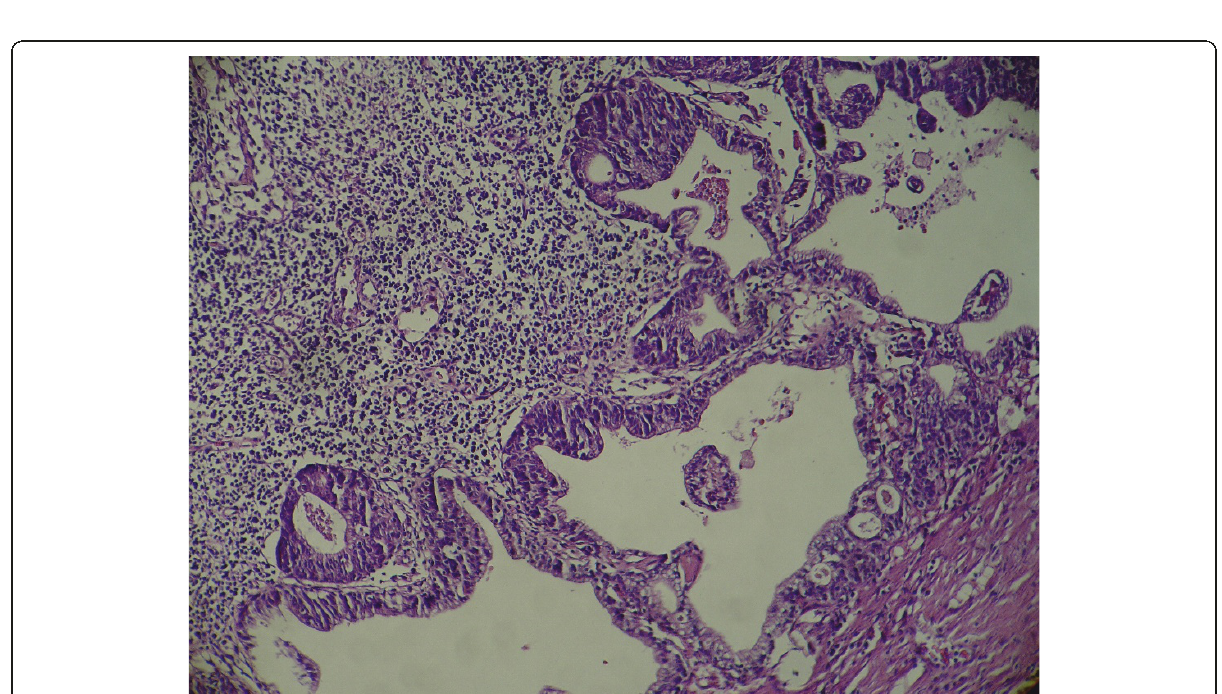
Figure 2 Metastatic lymph node; cystic structures in the metastatic cervical lymph node of the same case